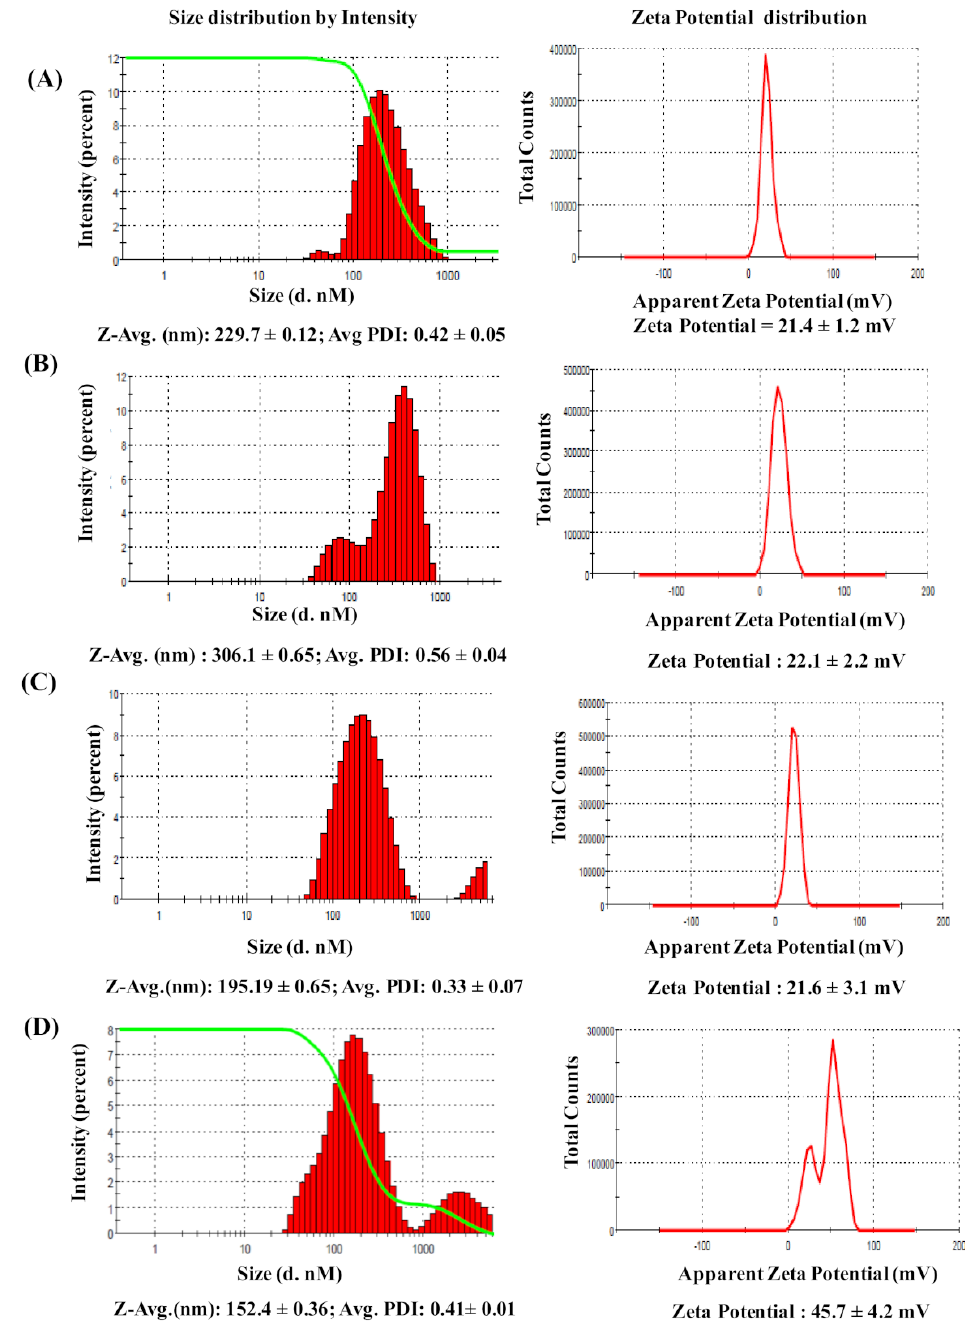
Figure 1. Dynamic light scattering (DLS) particle-size distributionsby intensity of experiments and Zeta potential of finally optimized ( A ) F1, ( B ) F2, ( C ) F3, and ( D ) F4 formulations measured by a Malvern Zetasizer Nano ZS. The average particle size in nm and polydispersity index (PDI) and Zeta potential in mV were shown for each formulation. All experiments were performed in triplicates; values are expressed as mean ± SEM. Besides, F1, F3 and F4 nanoparticles showed well polydispersity with PDI < 0.5. Zeta-potential analysis showed that F4 exhibited an indicated maximum cationic charge density (45.7 ± 4.2) in comparison to other formulations with average size (152.4 ± 0.36), which was better in comparison to all other formulations. It is also reported that nanoparticles with a Zeta potential above (+/ − ) 30 mV are stable in